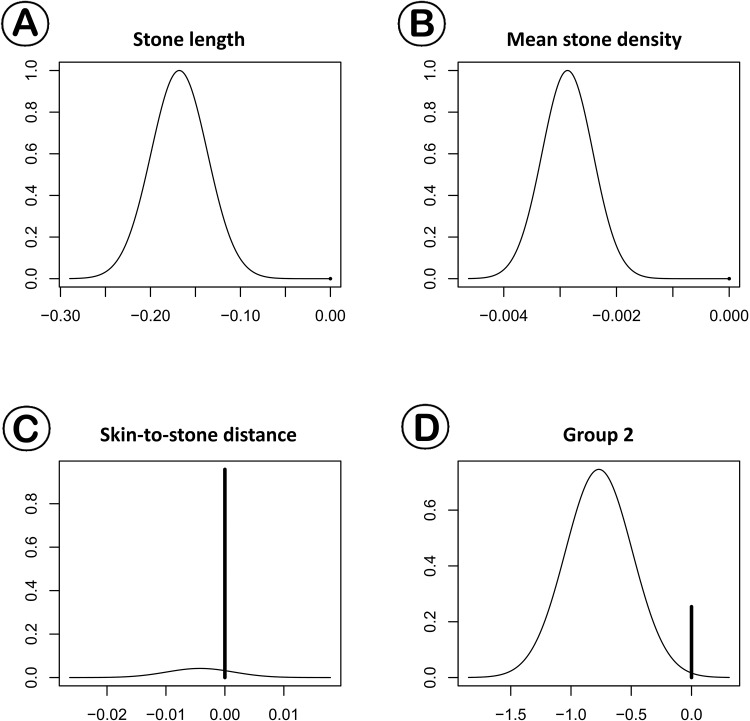
Posterior distribution plots of (A) maximal stone length (MSL), (B) mean stone density, (C) SSD, and (D) group 2 (versus others) in one session success.Shorter maximal stone length, lower mean stone density, and group 2 were also primarily distributed over the zero point for posterior probabilities.